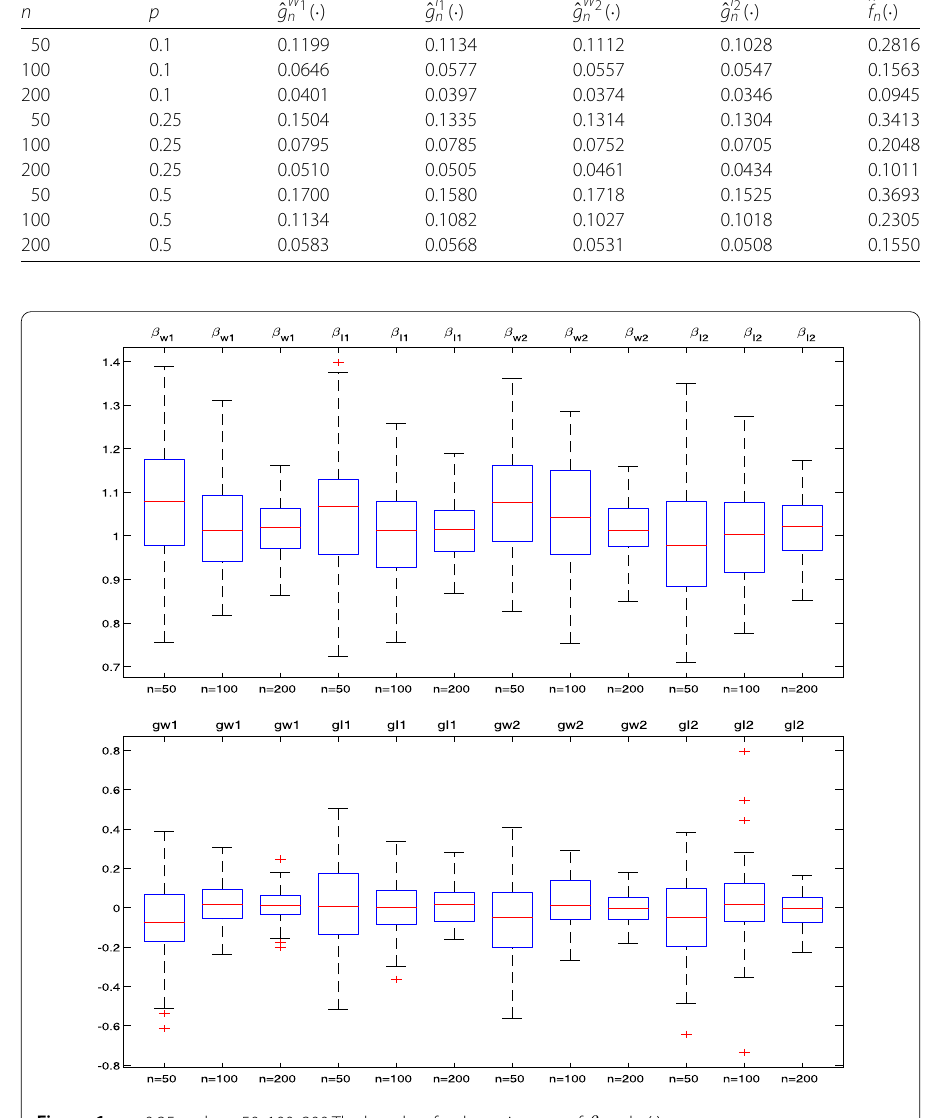
Figure 1 p = 0.25 and n = 50, 100, 200,The boxplots for the estimators of β and g ( ·